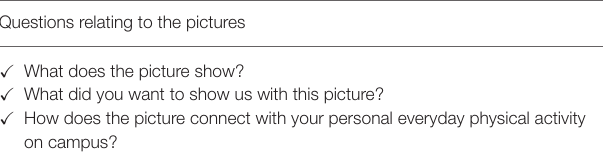
TABLE 2 | Questions guiding the focus group discussions of the